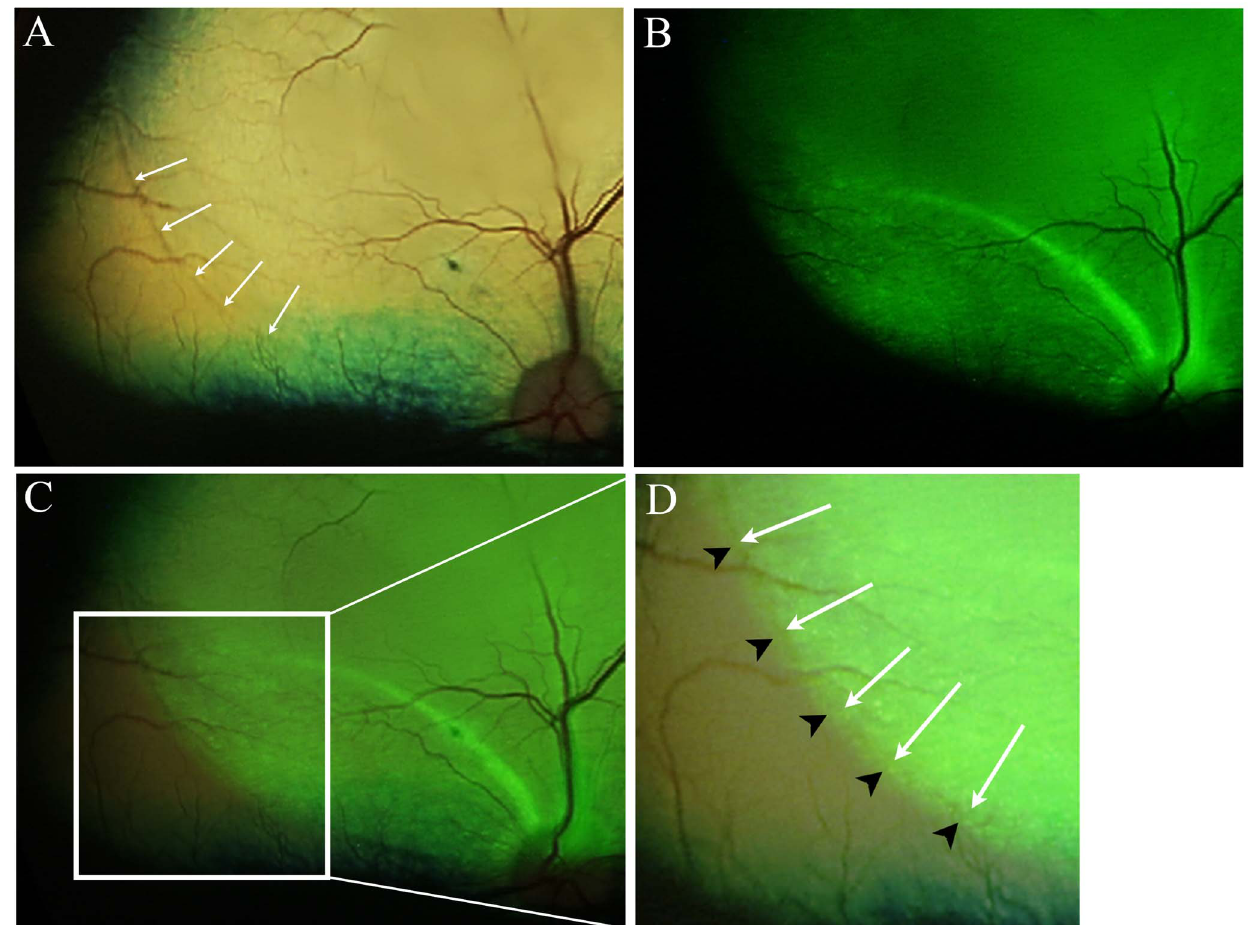
Figure 3. Expression of GFP beyond the final extent of the retinal detachment. Dog 1 OD – this eye received an injection of AAV2(quadY-F). A. Color fundus image following retinal reattachment after the subretinal injection. The final extent of the detachment can be seen as a color change in the tapetal fundus as indicated by arrows. B. The same eye imaged to show GFP expression. C. An overlay of the fundus images in A and B. D. An enlarged view of the region in C that is within the white box. The white arrows correspond to the arrows in A. The black arrow heads point out the extent of the GFP expression which extends slightly beyond the final boundary of the retinal detachment.